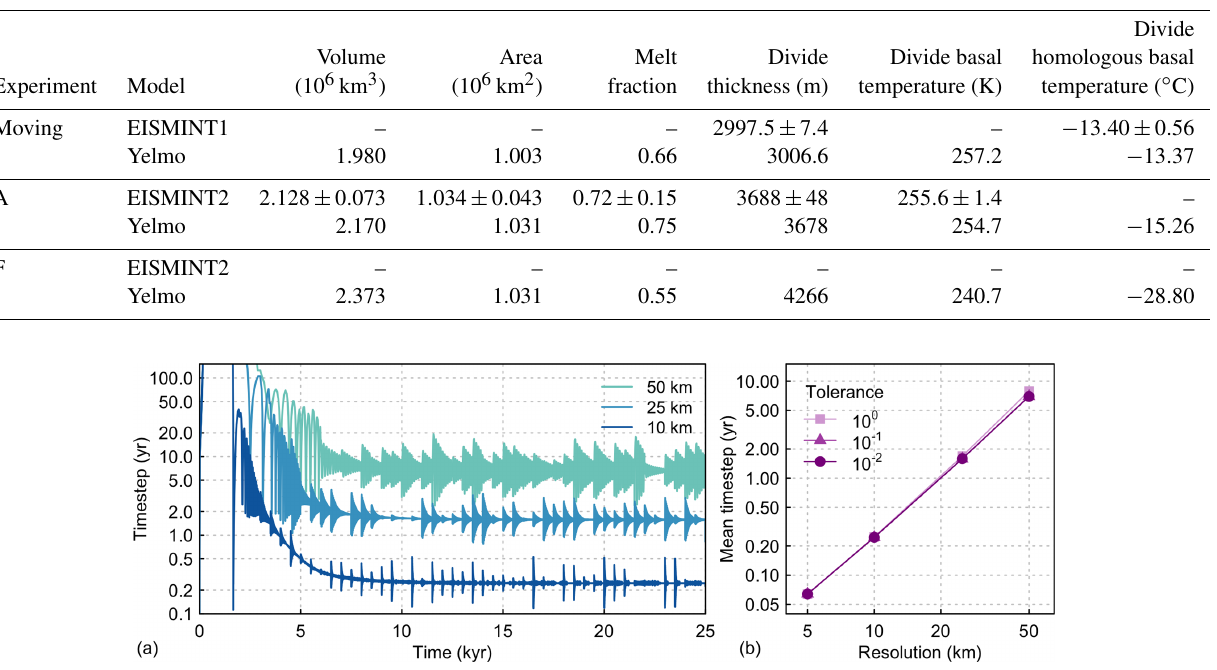
Table 1. Yelmo performance in the EISMINT1 moving margin experiment (“Moving”), as well as in the EISMINT2 experiments A and F. Where available, metrics with the ensemble mean and standard deviation from the original benchmark experiments are also provided for comparison.